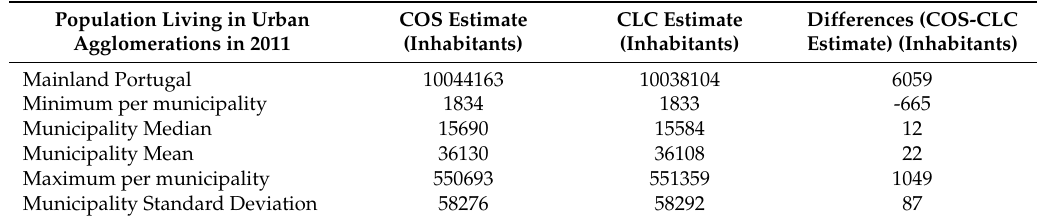
Table 3. Descriptive statistics on the population living in urban agglomerations estimated by COS and by CLC for